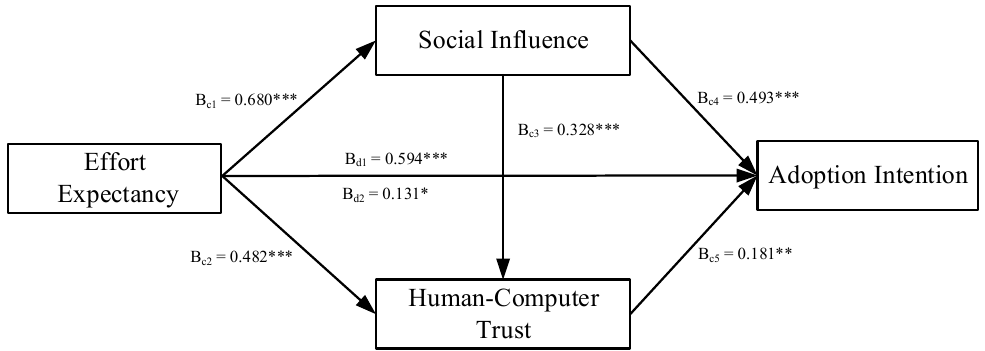
Figure 3. The serial multiple mediation model of effort expectancy. Note: c1, direct effect of effort expectancy on social influence; c2, direct effect of effort expectancy on human–computer trust; c3, direct effect of social influence on human–computer trust; c4, direct effect of social influence on adoption intention; c5, direct effect of human–computer trust on adoption intention; d1, total effect of effort expectancy on adoption intention; d2, direct effect of effort expectancy on adoption intention. * p < 0.05; ** p < 0.01; *** p < 0.001.